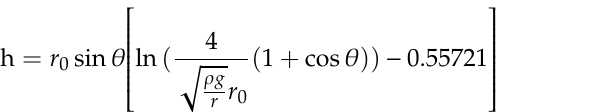
Figure 1. Experimental setup and instruments. ( A ) Ar atmosphere glove box. ( B ) Schematic diagram of experimental apparatus. ( C ) Oxygen and moisture monitoring. ( D ) Autolab/PGSTAT128N potentiostat ( E ) Electrode setup in glove box.